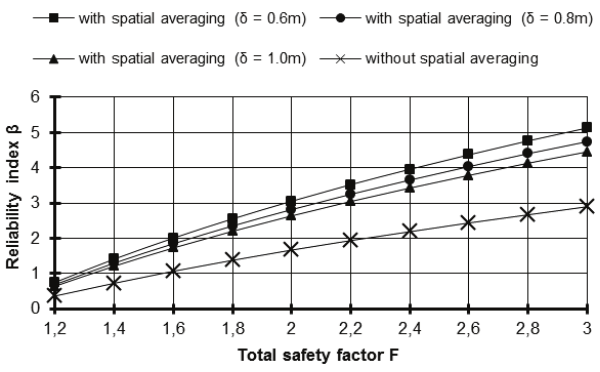
Fig. 5. The influence of spatial averaging on the values of reliability indices